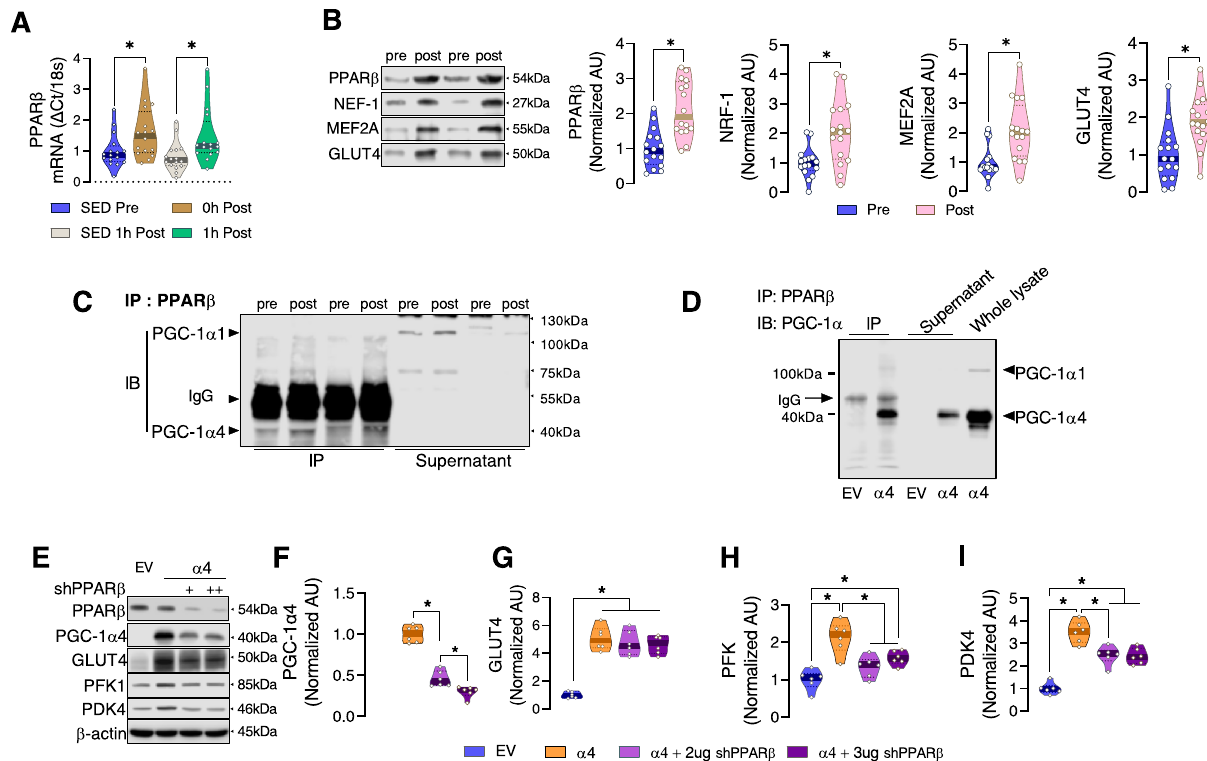
Fig. 5 Resistance exercise training-induced PGC-1 ɑ 4 cooperates with PPAR β to regulate glycolysis. A PPAR β mRNA was determined by qPCR in muscle biopsy samples of healthy participants before (SED Pre), within 10 min after (0 h Post), and 1 h after (1 h Post) a one-legged resistance exercise (RE) bout ( n = 16). Time-matched control muscle samples were obtained from the non-exercised leg at 1 h post-RE (SED 1 h Post) ( n = 16 per group). One-way ANOVA was used with multiple comparisons. B Protein abundance of PPAR β and its downstream related proteins was determined in muscle before (Pre) and after (Post) RET. Representative immunoblots for each protein and quanti fi cation of the relative change after training for PPAR β , NRF-1, MEF2A, and GLUT4 are displayed ( n = 16). Paired two-tailed t -tests were used. C PPAR β was immunoprecipitated from pooled muscle samples before (pre) and after (post) RET, then the immunoprecipitate was immunoblotted for PGC-1 α 1 and PGC-1 α 4 to determine binding between PPAR β with PGC-1 α 1 and PGC-1 α 4. Owing to the large amount of protein required to immunoprecipitate enough PPAR β for immunoblot detection of PGC-1 α 1 and PGC-1 α 4, samples of multiple participants before and after training were pooled together, resulting in a smaller n for PGC-1 α isoform quanti fi cation ( n = 2). D The binding between PPAR β and PGC-1 α isoforms was con fi rmed using cells overexpressing PGC-1 α 4. Experiment shown in panel D was performed once. E – I PPAR β was silenced by shPPAR β overexpression in myotubes, then PGC-1 α 4 was overexpressed ( n = 6). The abundance of some of the important glycolytic proteins (GLUT4, PFK1, and PDK4) was determined by immunoblotting. One-way ANOVAs were used with multiple comparisons. * P < 0.05. Values are expressed as individual data points. Signi fi cant labeled P -values in each panel from left to right are as follows: panel A = 0.024 and 0.020; panel B = < 0.001, 0.002, <0.001, <0.001; panel F = < 0.001 and 0.010; panel G = < 0.001; panel H = < 0.001, <0.001, and <0.018; panel I = < 0.001, <0.001, and